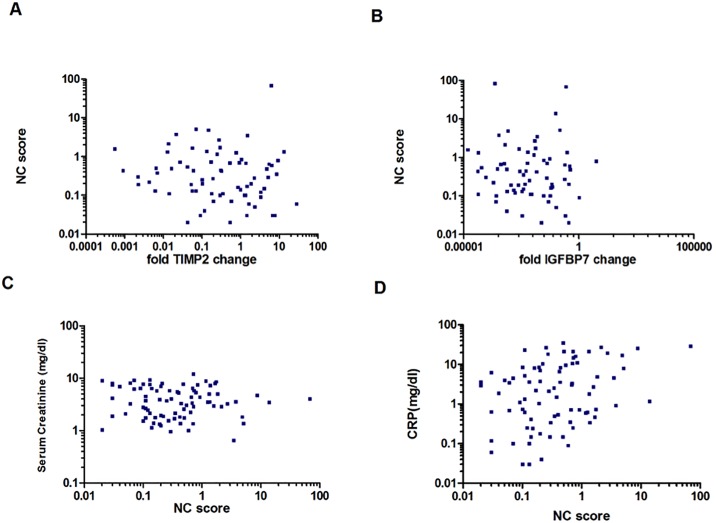
Correlation of NC-score with relative change of TIMP-2 and IGFBP7 expression, sCr and CRP.A) Pearson square pairwise correlation of NC-score with relative change of TIMP-2 mRNA expression in urinary sediment cells taking three normal kidney tissues as reference level. B) Pearson square pairwise correlation of NC-score with relative change of fold IGFBP7 change in urinary sediment cells taking three normal kidney tissues as reference level. C) Pearson square pairwise correlation of NC-score with serum creatinine levels (mg/dl) (r = -0.0283, p = 0.3995). D) Pearson square pairwise correlation of NC-score with CRP (mg/dl) (r = 0.3382, p = 0.0009).